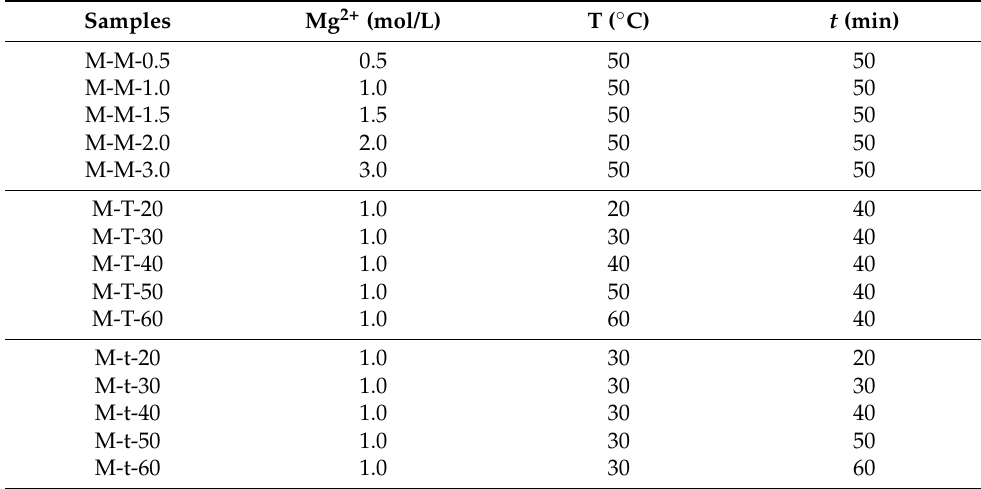
Table 1. The sample labels and reaction conditions of the synthetic nano-Mg(OH) 2 . Samples Mg 2+